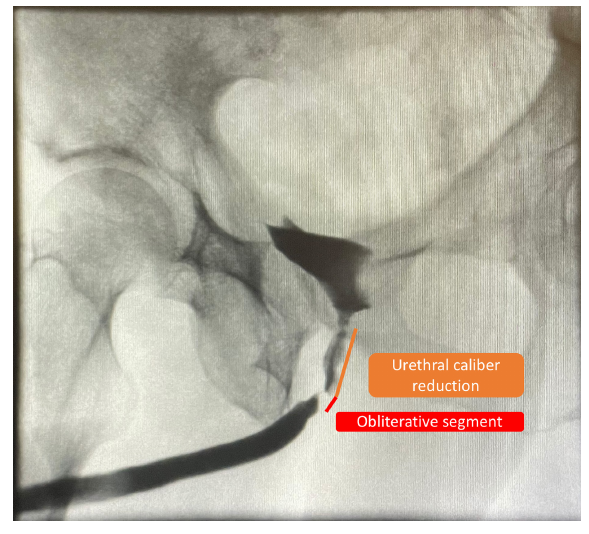
Figure 4. Urethrogram: bulbar urethral stricture.